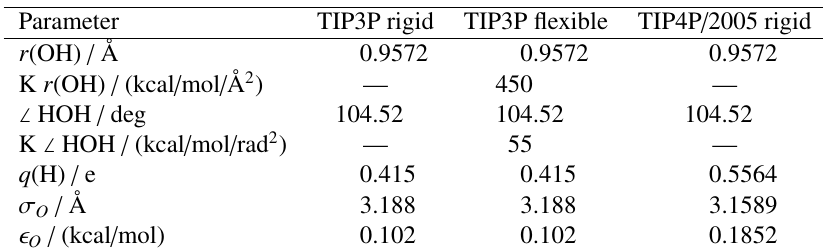
Table 1. Table of the force field parameters used in the MD simulations. Hydrogen atoms did not participate in Lennard-Jones interactions. The flexible model used harmonic intramolecular potentials.